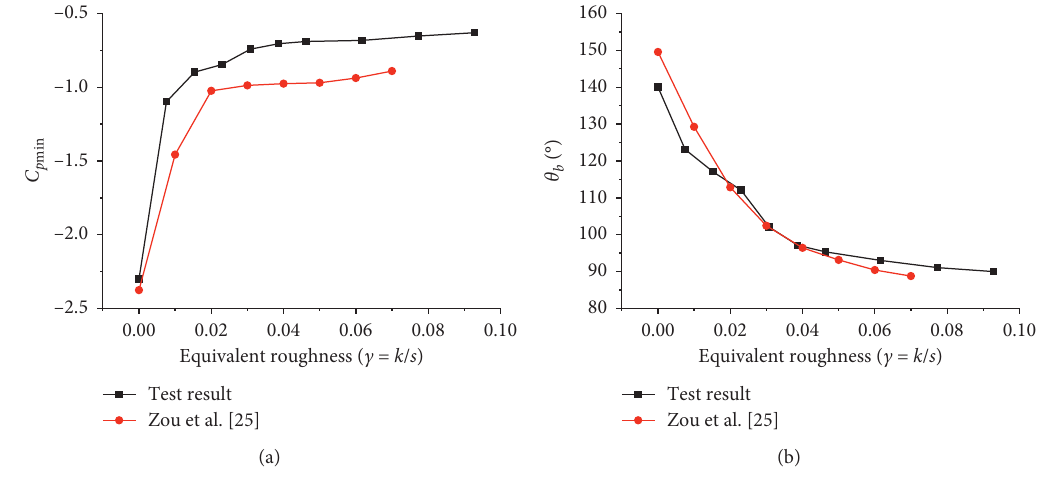
Figure 15: Effects of roughness on C p min and θ b : (a) minimum pressure coefficient and (b) azimuthal angle of separation point.